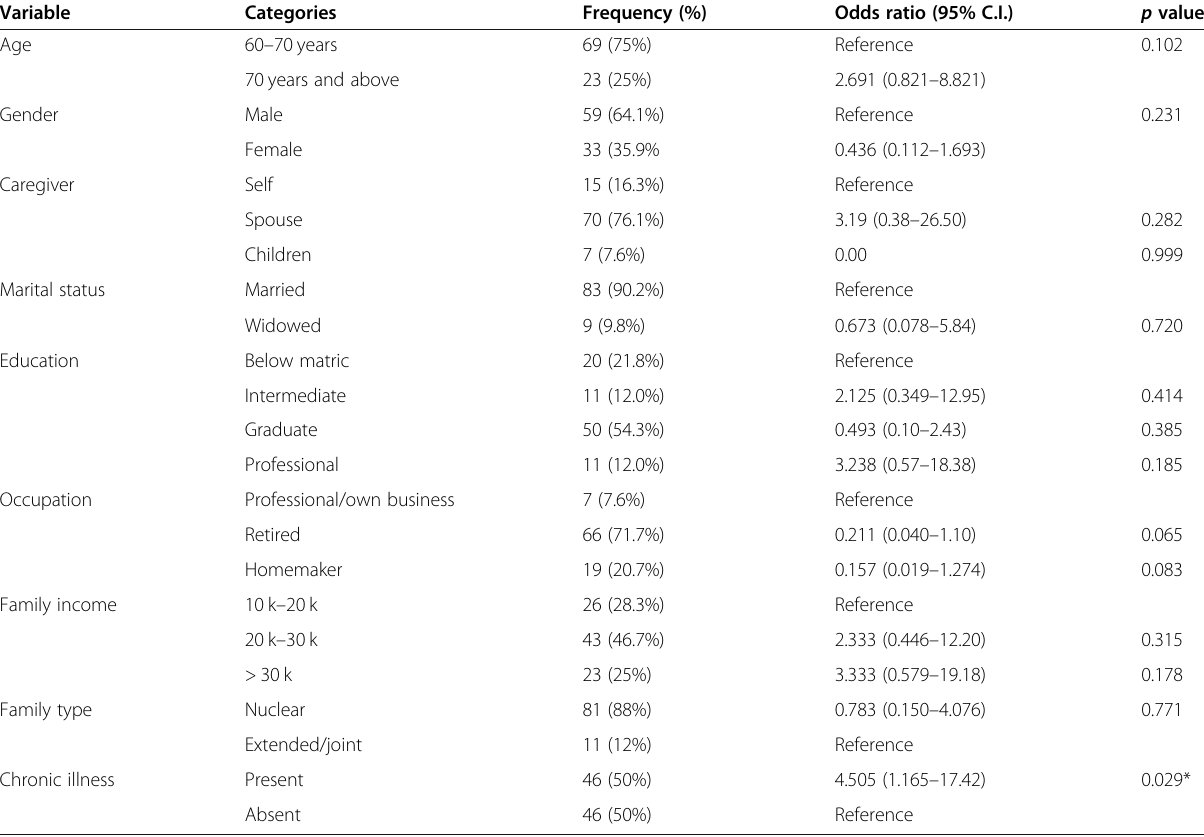
Table 1 Demographic characteristics of the geriatric sample and univariate analysis with odds ratio (95% C.I) for